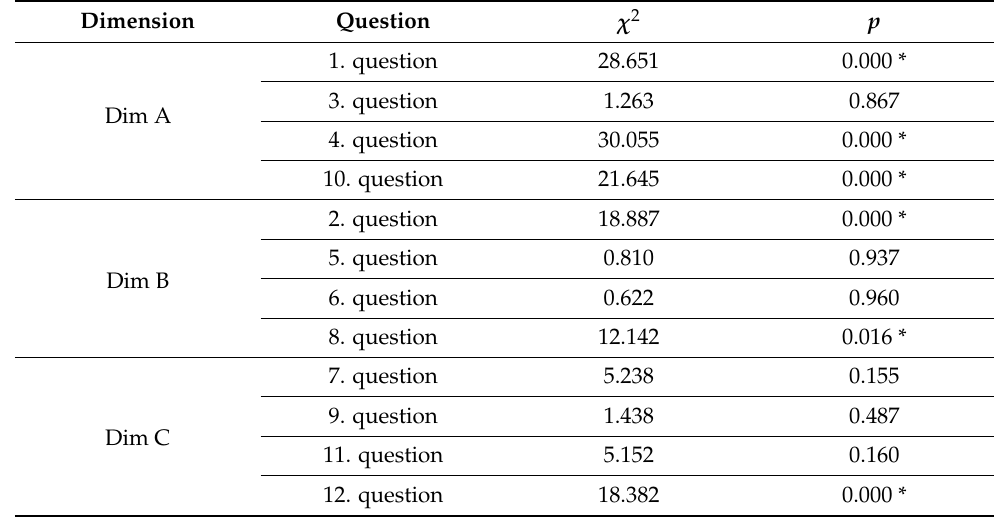
Figure 3. Average values of answers to questions in both tests. Table 5. Test results (pre-test and post-test).